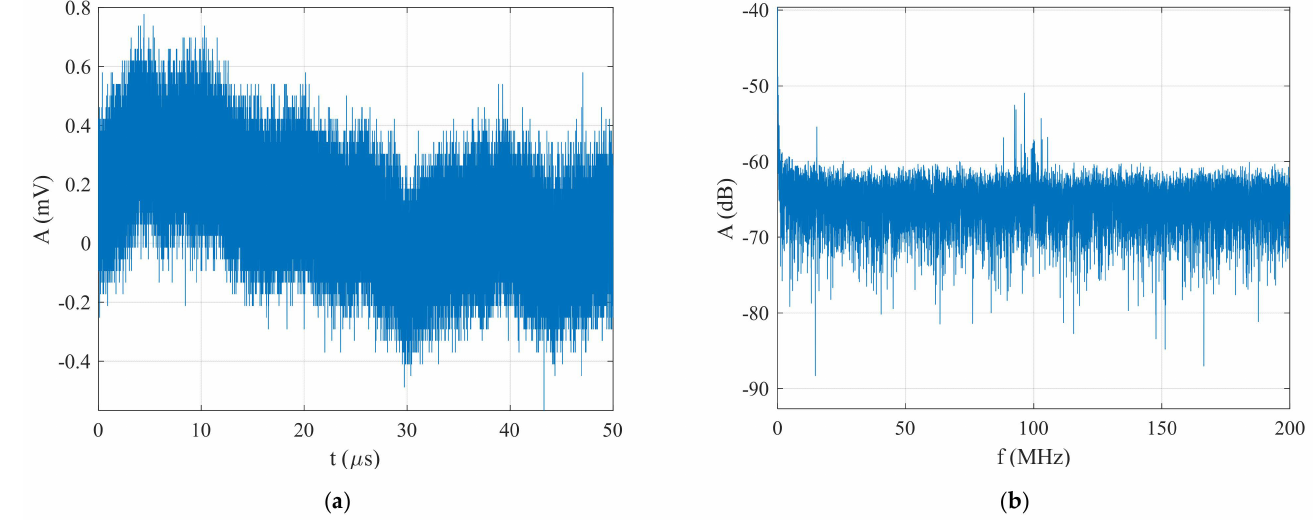
Figure 13. The generated BPSK signal in the form of Barker Code 13 at an SNR = − 26 dB : ( a ) time domain, and ( b )